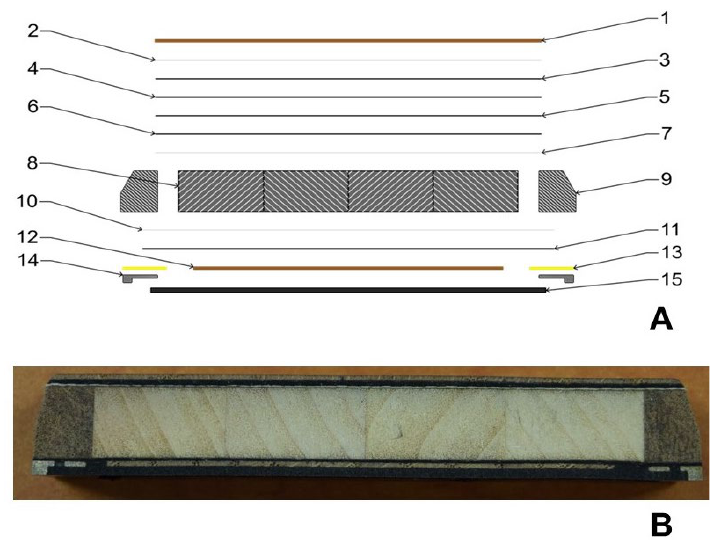
Figure 2. Hybrid sandwich structure of the tested ski: ( A ): Composition and relative arrangement of materials in the ski structure, ( B ): cross section of the tested ski.